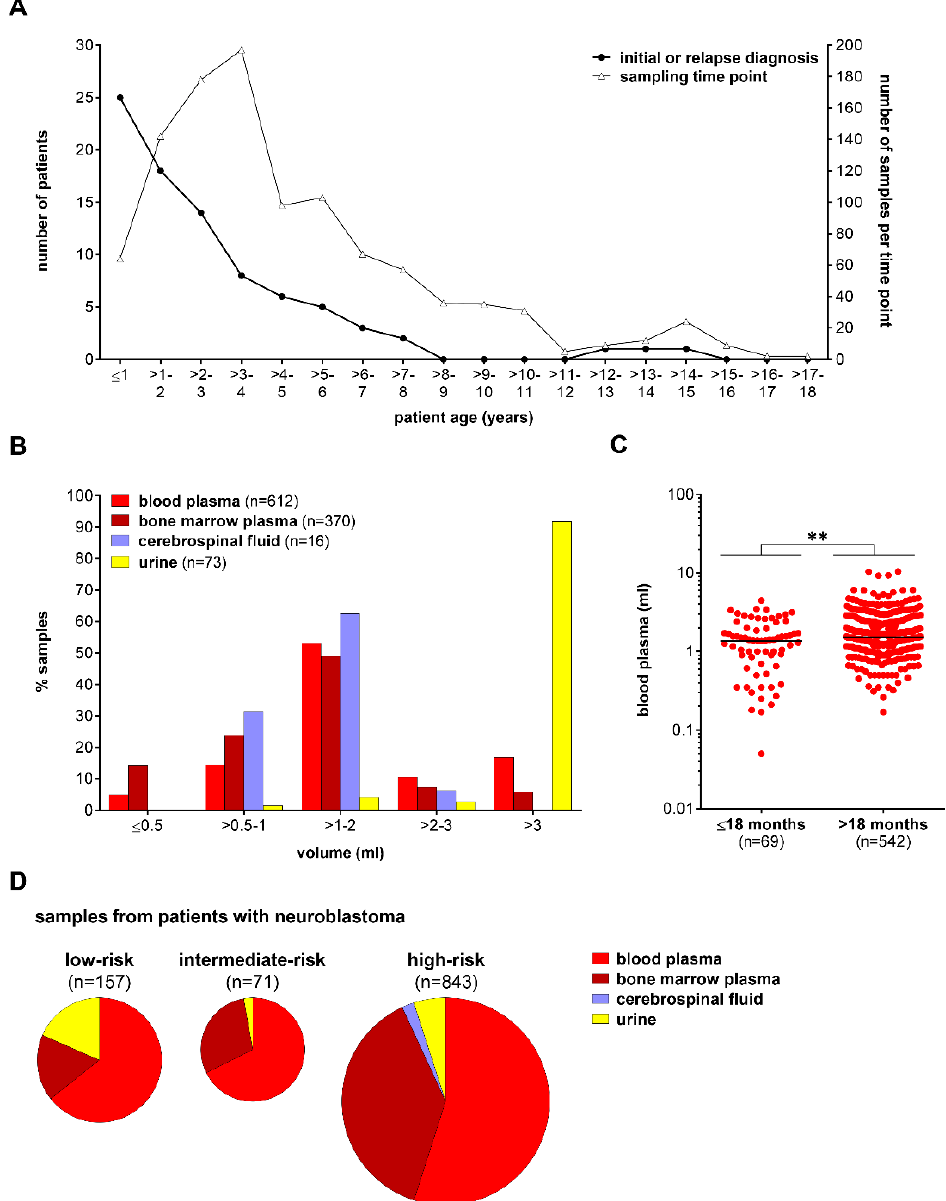
Figure 1. Overview of liquid biosamples from patients with neuroblastoma. ( A ) Line chart summa- rizing patient age at diagnosis and patient age at individual sample time point for the sequentially collected biofluids. ( B ) Bar chart indicating the percentage of biofluids according to sample volume. ( C ) Dot chart demonstrating blood plasma volumes provided from patients ≤ and >18 months of age. ** p < 0.01. ( D ) Multiple pie charts visualizing the distribution of biosamples collected in this study according to treatment stratification of patients with neuroblastic tumors [38].